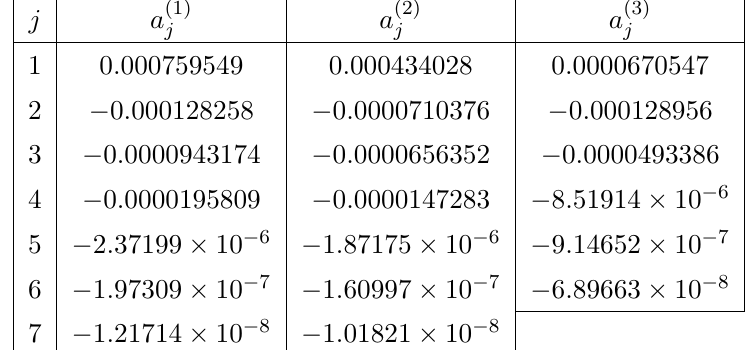
for eq. (B.7) and eq. (B.10). j